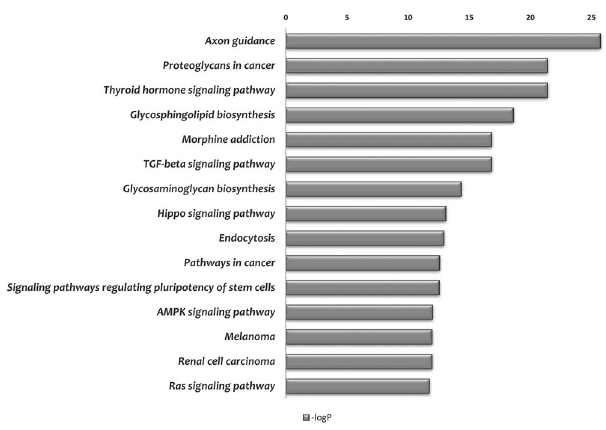
Figure 5. Pathway analysis of the deregulated miRNAs. Significant targeted KEGG pathways identified by top 100 deregulated miRNAs. X-axis indicates the log transformed p-value (significant level) between miRNAs and each